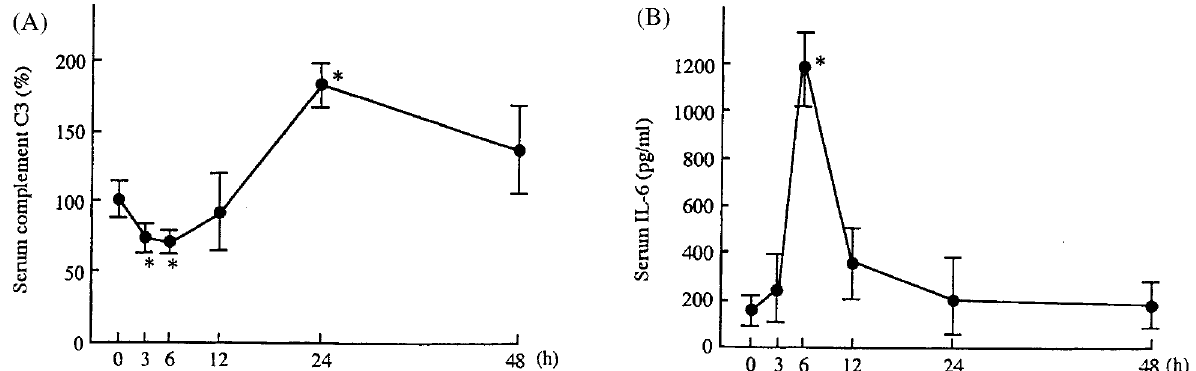
FIG. 1. Changes in serum concentrations of complement C3 (A) and IL-6 (B) in mice treated with intraperitoneal carrageenan. * P <0.05 compared with the control (time = 0). Data are mean ± SD of five